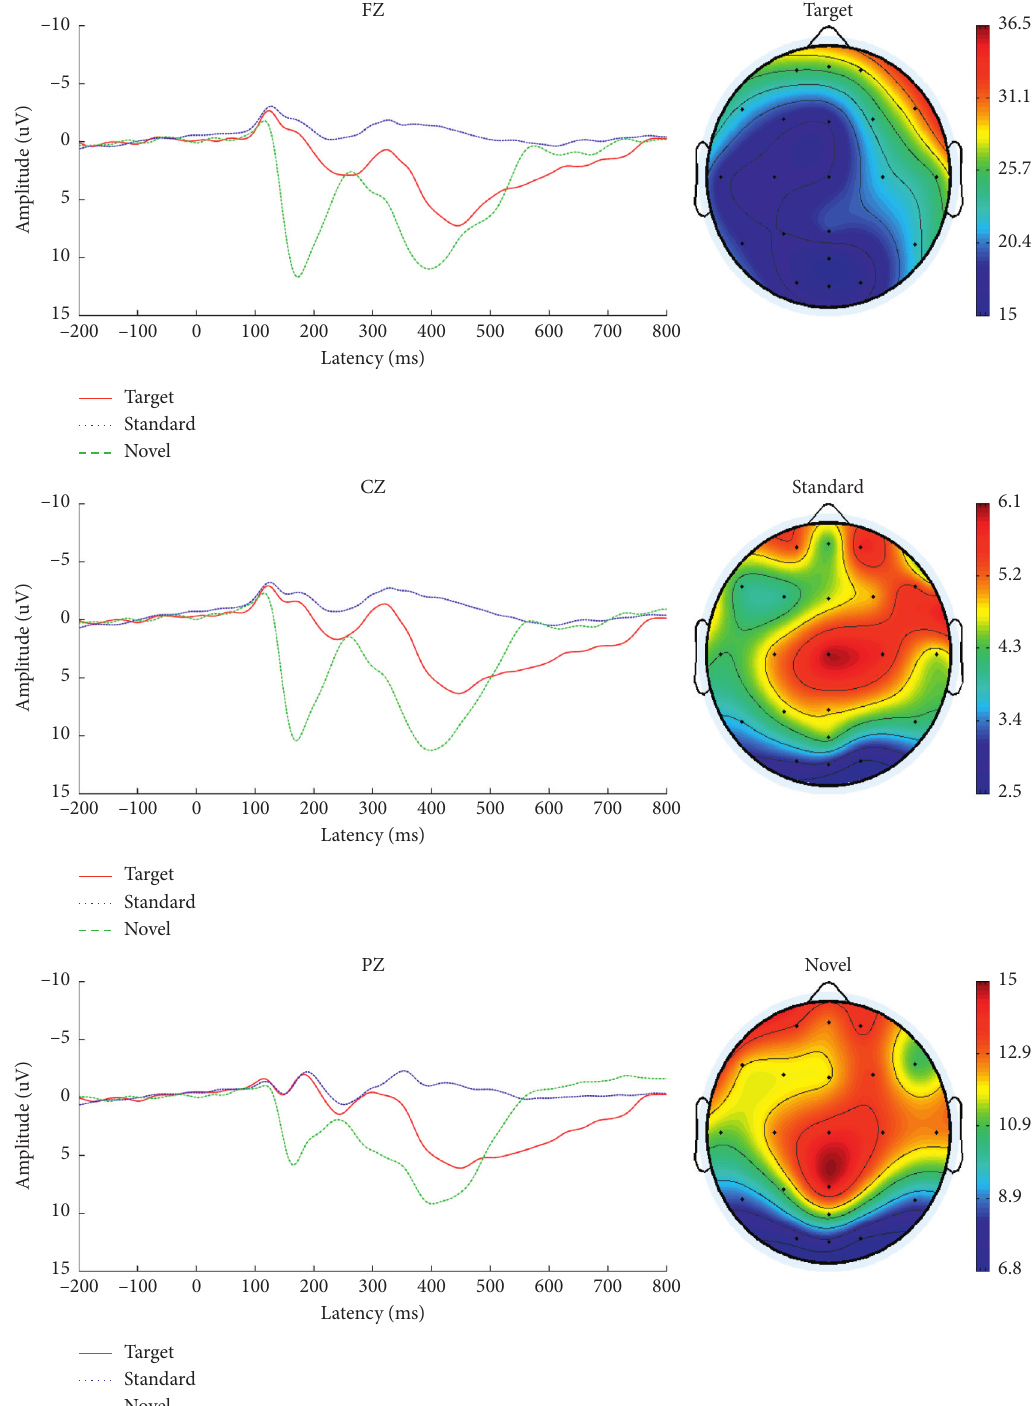
Figure 2: (a) Grand-averaged waveforms (mean across the 25 participants and 3 types of stimuli) on Pz, Cz, and Fz electrodes: target stimuli (red), standard (blue), and novels (green). (b) Topography distributions for the mean target (A), standard (B), and novel (C) bilateral insula. Figure 3(c) and Table 3 illustrate the activation 3.3. fMRI Data. Figure 3(a) and Table 1 illustrate the activation for the novel-target contrast. These included the left fronto- for the novel stimuli. The novels activated the left frontopartietal parietal areas, the left postcentral, and the left fusiform. areas, left precuneus areas, and the right insula. Figure 3(b) and Gray reflects the background baseline state of the ce- Table 2 illustrate the activation for the target stimuli. The targets rebral cortex; the darker the color, the closer to orange-red, activated the bilateral fusiform gyrus, left frontal areas, and